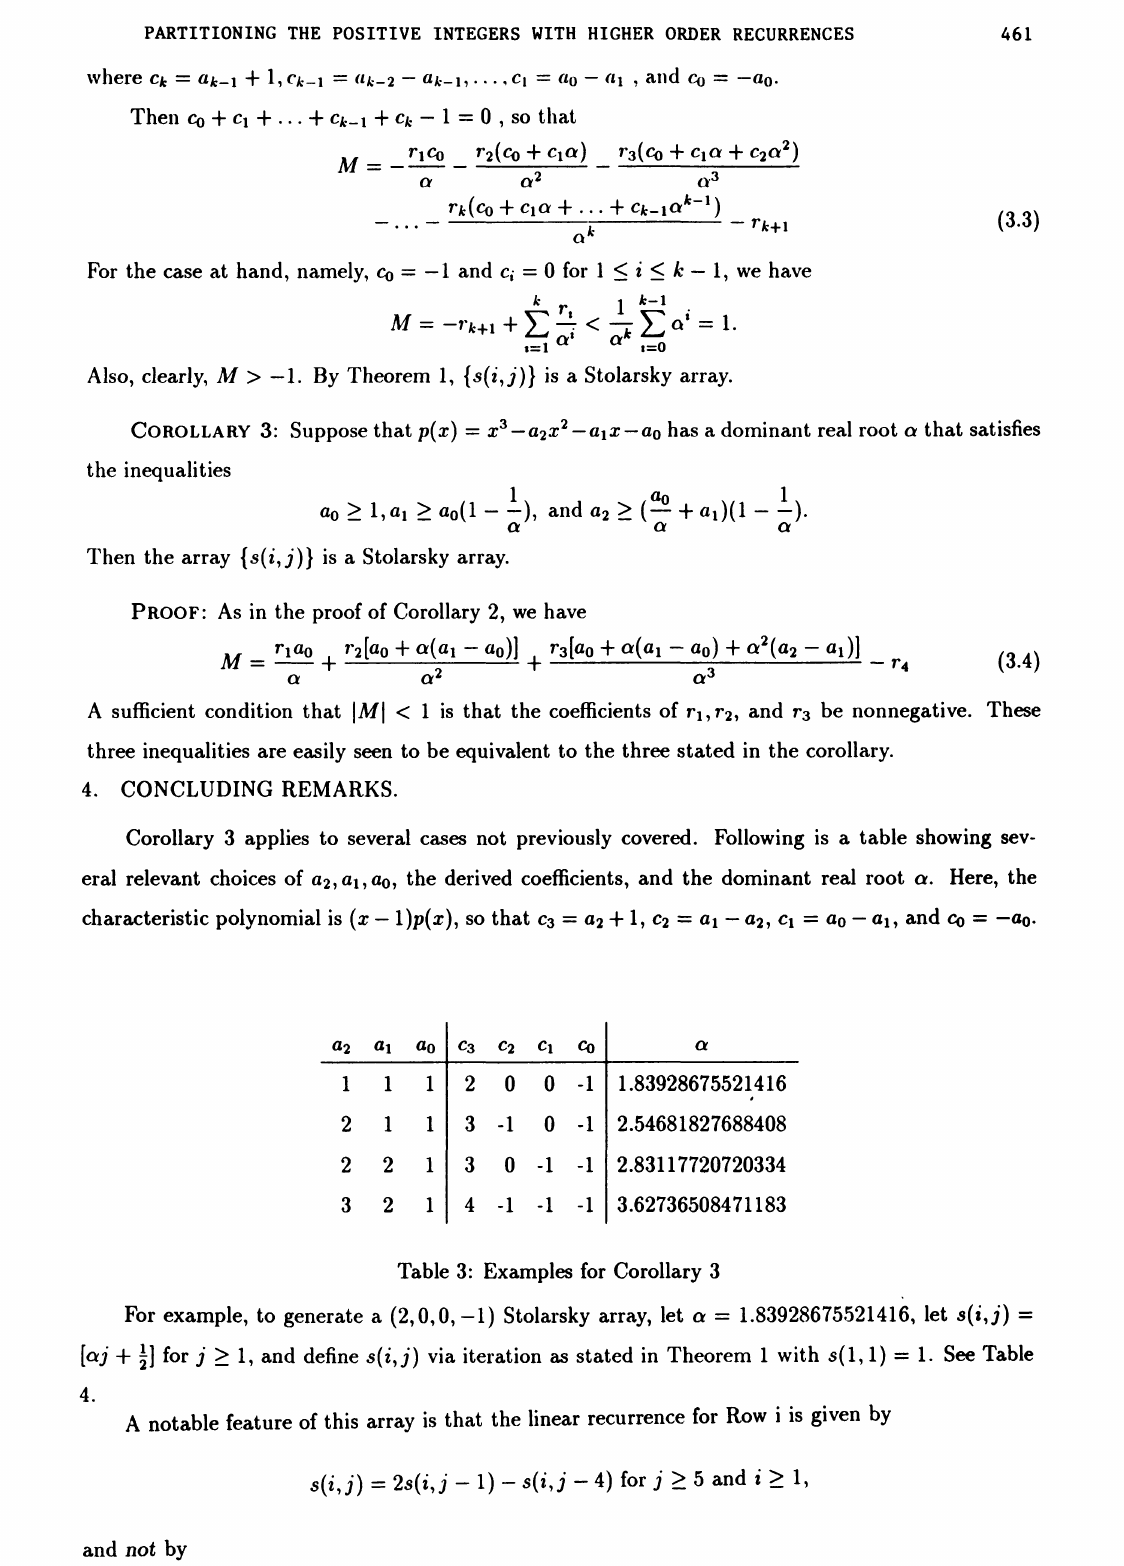
Table 3: Examples for Corollary